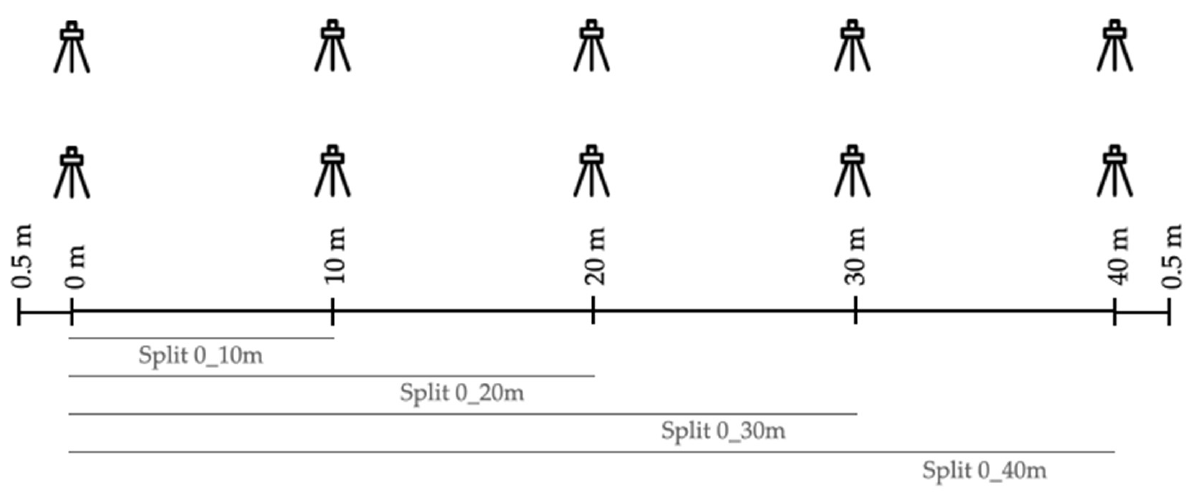
Figure 2. Diagram of the placement of the photocells in the RSA.